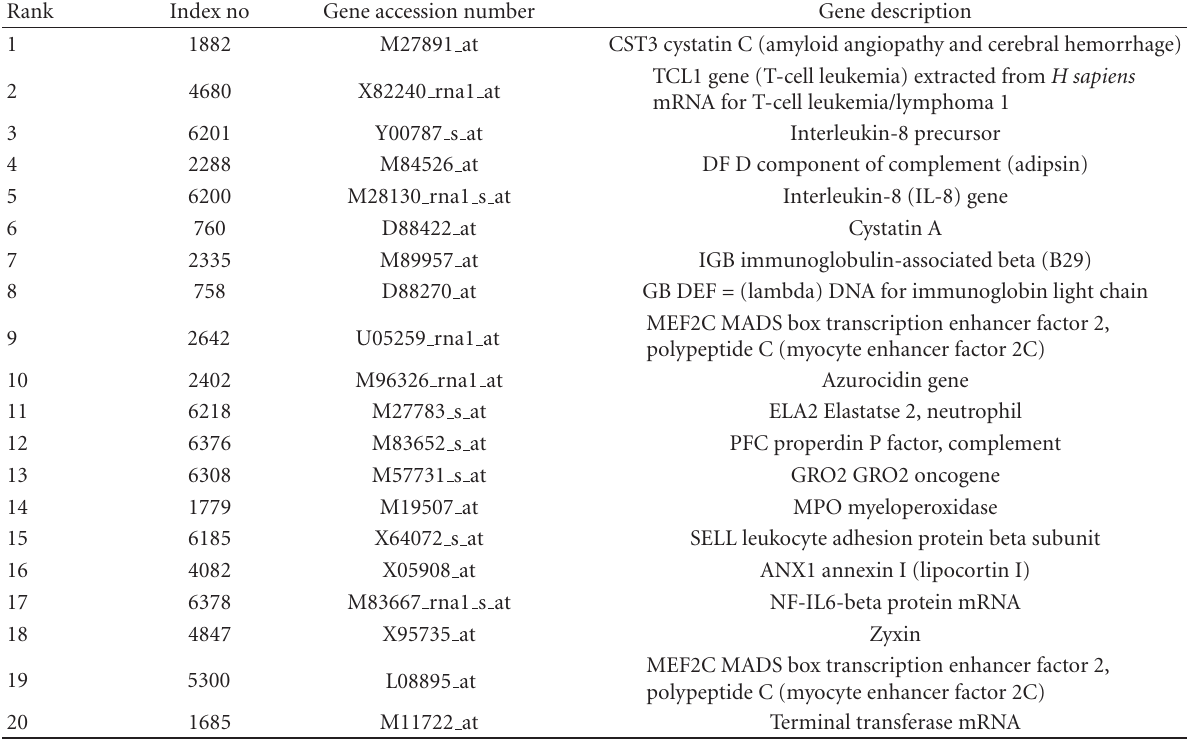
Table 8. A part of the strongest genes selected in small round blue-cell tumors dataset (the second row of genes in Table 4).